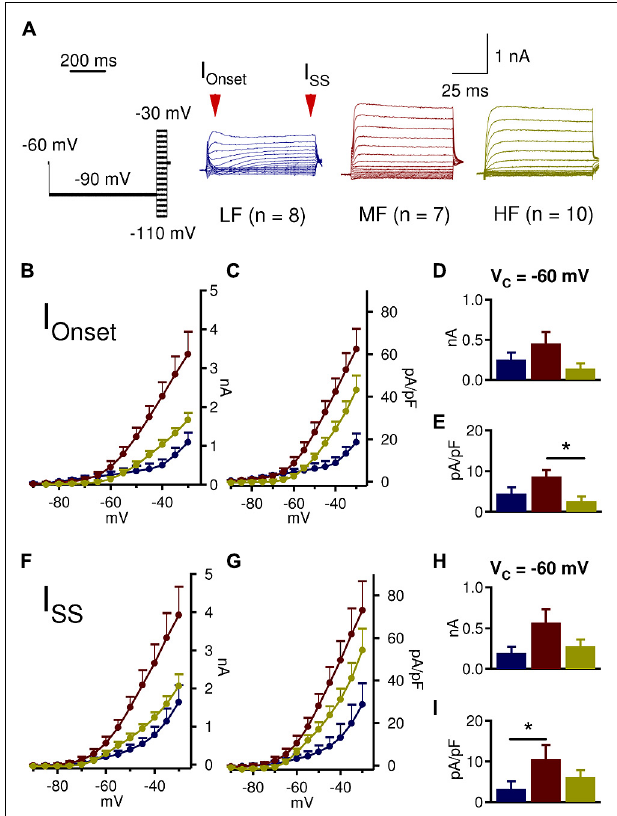
FIGURE 3 | MF neurons have higher LTK conductance active at rest. (A) Sample protocol (V hold = − 60 mV,V prepulse = − 90 mV, 1000 ms duration;V c = − 110 to − 30 mV, 100 ms duration), and representative LTK current recordings from LF (blue, n = 8), MF (red, n = 7), and HF (yellow, n = 10) NL neurons. (B–E) At − 60 mV, MF (0.5 ± 0.1 nA) neurons appear to have higher I Onset amplitude than LF (0.3 ± 0.1 nA) and HF (0.2 ± 0.1 nA) neurons.The I Onset density at − 60 mV in MF (8.9 ± 1.9 pA/pF) neurons is significantly higher than in HF (2.1 ± 1.7 pA/pF) neurons, while LF neurons have intermediate current density (4.3 ± 1.9 pA/pF). (F,G) I SS amplitude and current density reveal similar tonotopic variations to I Onset . (H) I